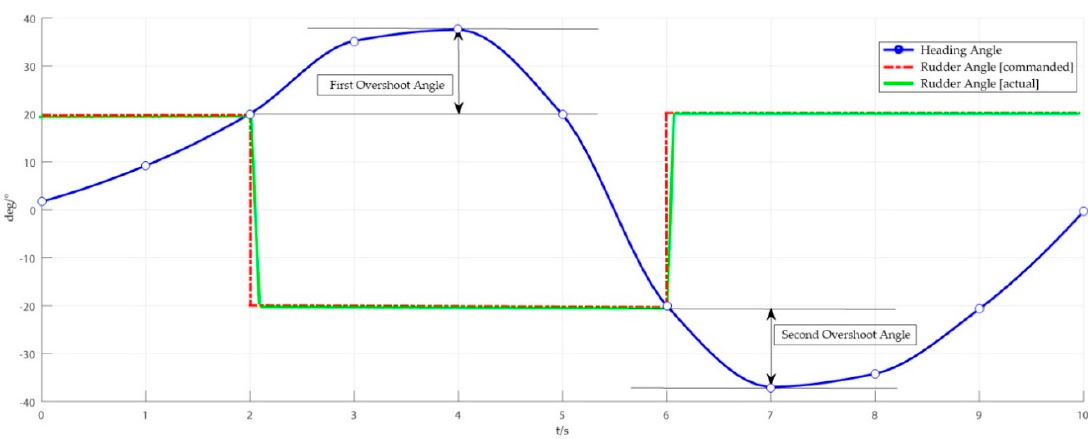
Figure 6. Rudder response of zig-zag test.